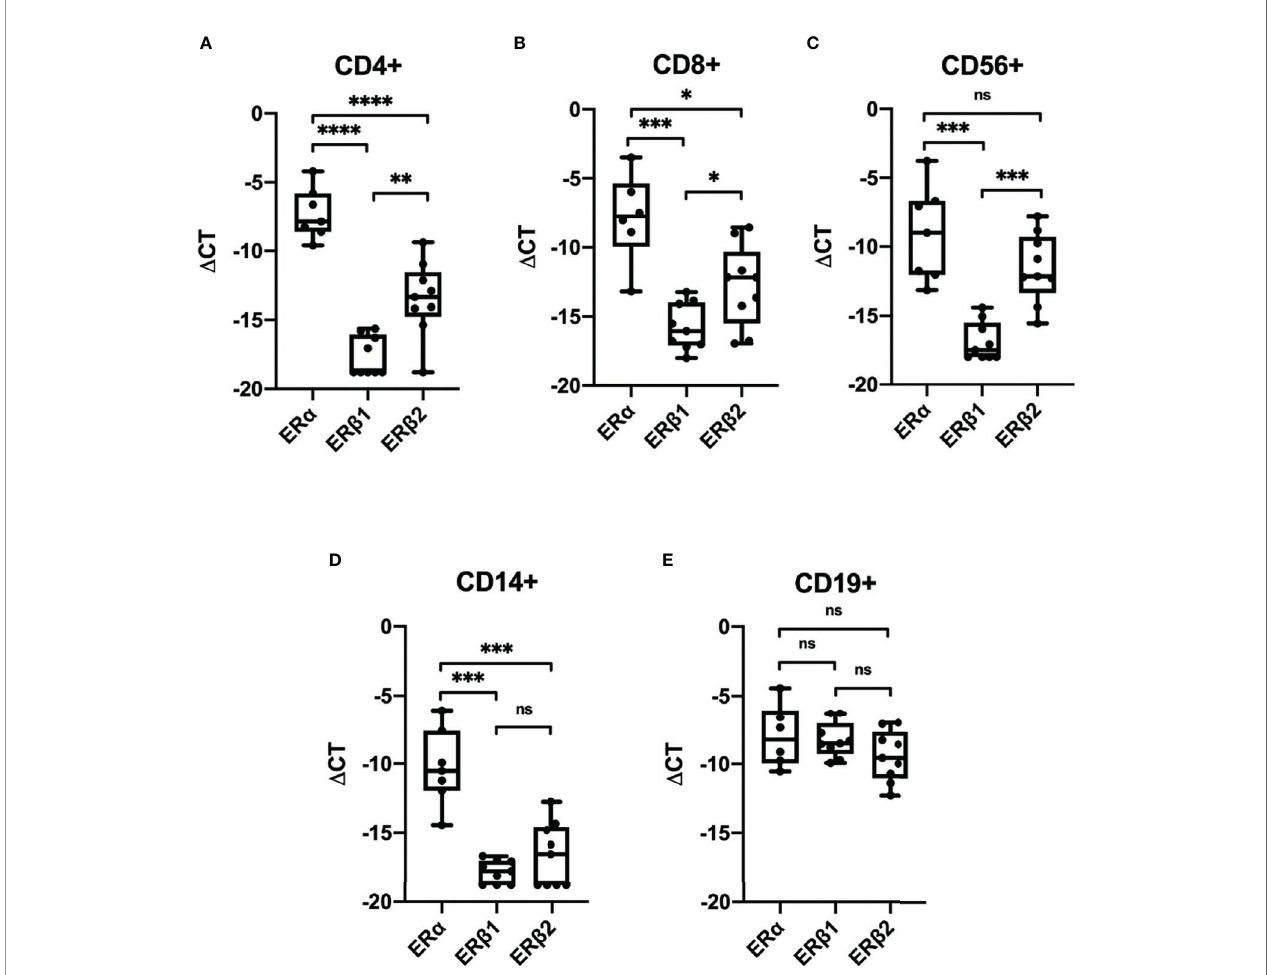
FIGURE 1 | Expression of estrogen receptors in sorted PBMCs. Relative expression ( D CT relative to GAPDH) of ER a ( ESR1 ), ER b 1 ( ESR2_ERb1 ) and ER b 2 ( ESR2_ERb2 ) in CD4 + T-cells (A) , CD8 + T-cells (B) , CD56 + NK-cells (C) , CD14 + monocytes (D) , and CD19 + B-cells (E) from men, pre-MP and post-MP women ( n = 6 – 9). P values were obtained using Welch ’ s t-test, * p < 0.05, ** p < 0.01, *** p < 0.001, **** p < 0.0001, ns, not signi fi